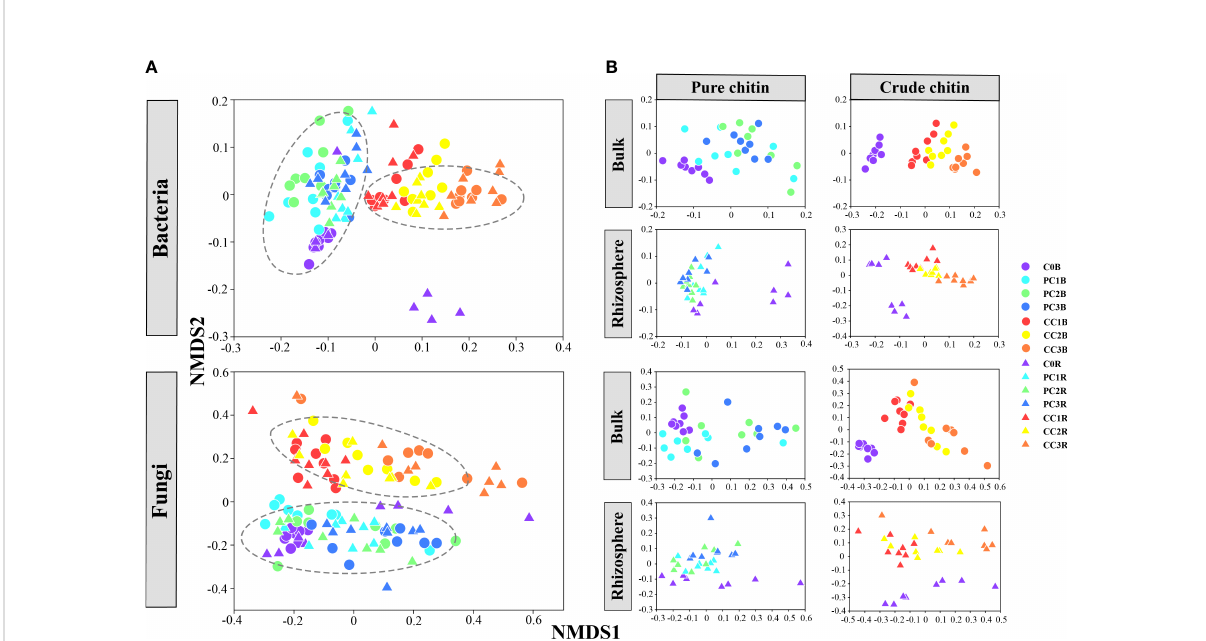
FIGURE 1 Nonmetric multidimensional scaling (NMDS) plot of all soil bacterial and fungal communities (A) . The separated NMDS plots showed the effects of pure and crude chitin amendments on the bacterial and fungal community structures in the bulk and rhizosphere soils, respectively (B) . C0, PC1, PC2, PC3 and CC1, CC2, CC3 represent the pure and crude chitin amendment rate at 0%, 0.05%, 0.1%, 0.2% and 0.5%, 1%, 2% of total soil mass, respectively. B, bulk soil; R, rhizosphere